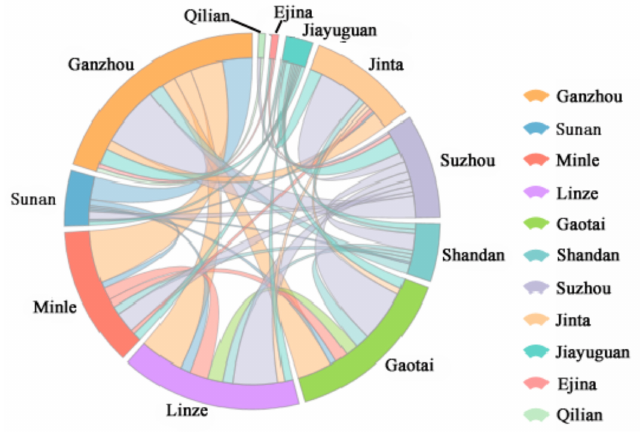
Figure 2. Virtual water imports and exports at the county level for the Heihe River Basin. The color of the links refers to the